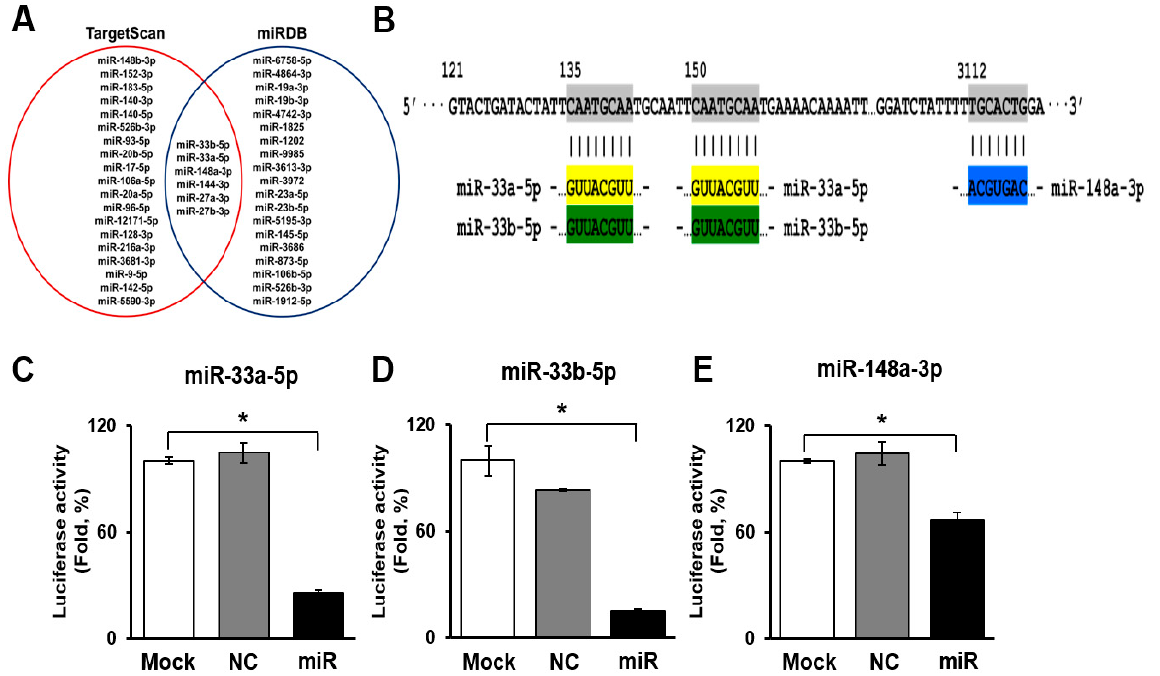
Figure 2. miRNAs targeting ABCA1. ( A ) Venn diagram of miRNAs targeting ABCA1. ( B ) The 3 ′ UTR of the ABCA1 gene containing miRNA binding sites for miR 33a-5p, miR-33b-5p, and miR-148a-3p. Luciferase assays to validate the interaction of miR-33a-5p ( C ), miR-33b-5p ( D ), and miR-148a-3p ( E ) with ABCA1. Mean ± SD ( n = 3 per group); * p < 0.05; t -test. NC, negative control; miR, miR transfected group.